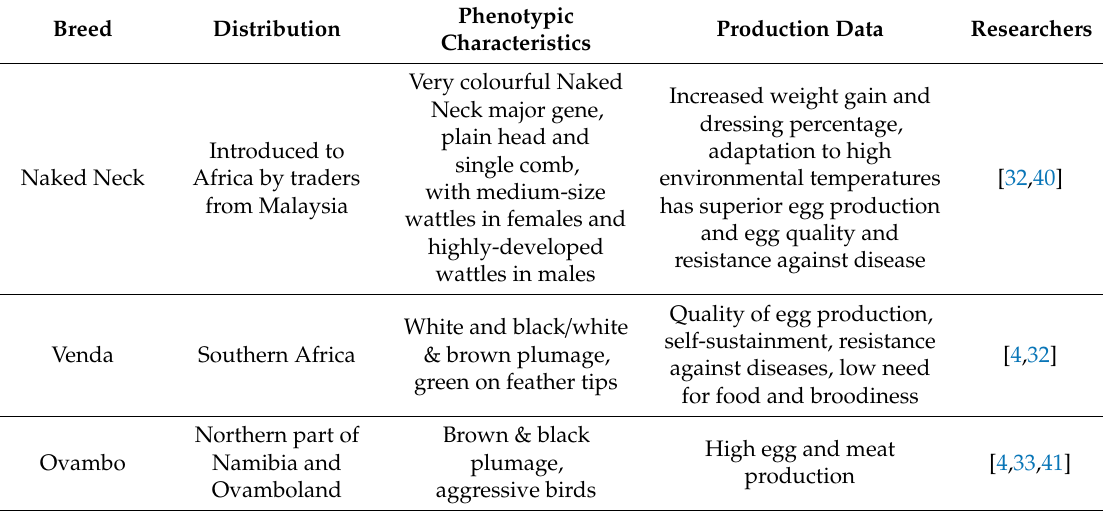
Table 1. Summary of distribution, phenotypic characteristics, production / performance traits of local / cross breed